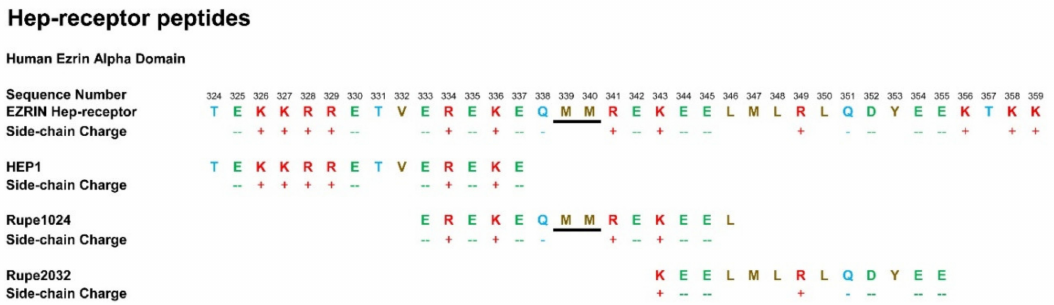
Figure 13. Over-lapping synthetic peptides mimicking the two helices and the MM hinge of the Hep-receptor of ezrin. The colours represent the physical amino acid properties: brown; hydrophobic, blue; polar uncharged, red; polar +ve charged, green polar –ve